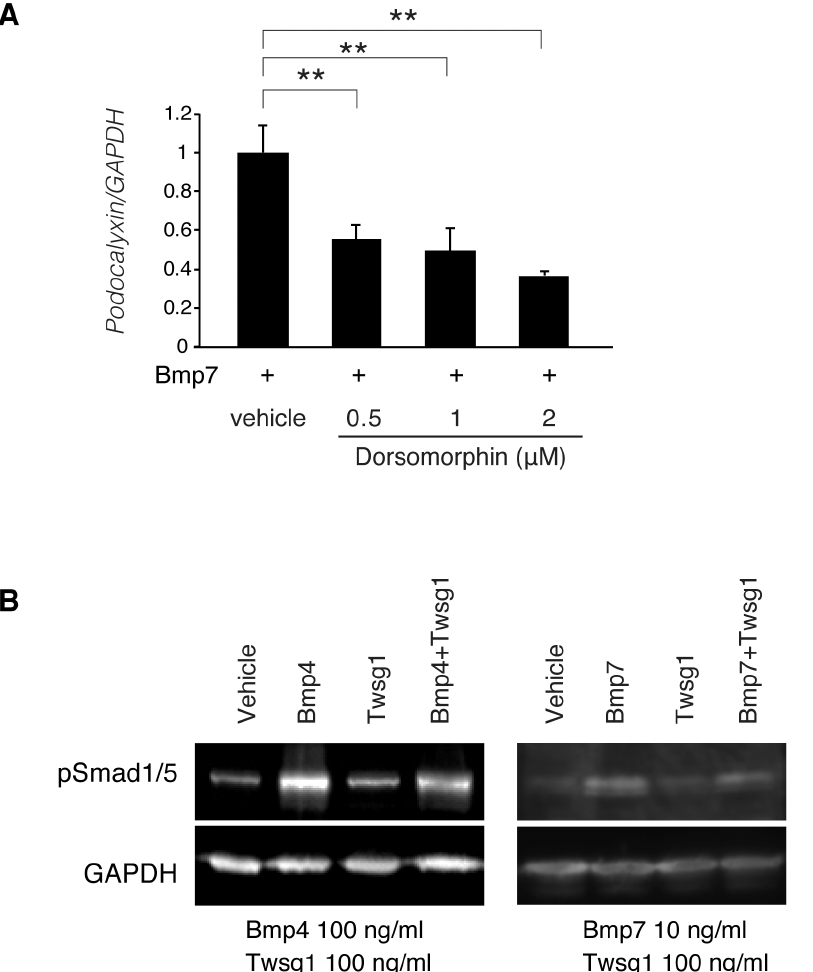
Figure 2. Smad signaling in podocyte differentiation and Twsg1 antagonism. (A) The results of quantitative real-time PCR analysis of podocalyxin in the presence or absence of dorsomprohin. Bmp7 (10 ng/ml) and each concentration of dorsomphin were added to the podocyte. Data are presented as means 6 SD. n=3. **, p , 0.01. (B) Western blotting of podocytes treated with Bmp proteins and Twsg1. Podocytes treated with these proteins were subjected for western blotting. Representative data is shown. GAPDH was utilized as a loading control.